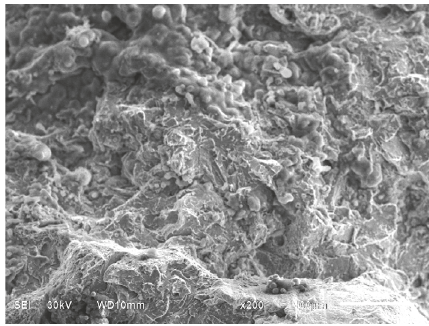
Figure 6: Fracture morphology of 4340 in 100 ∘ C oxygen-containing distilled water.